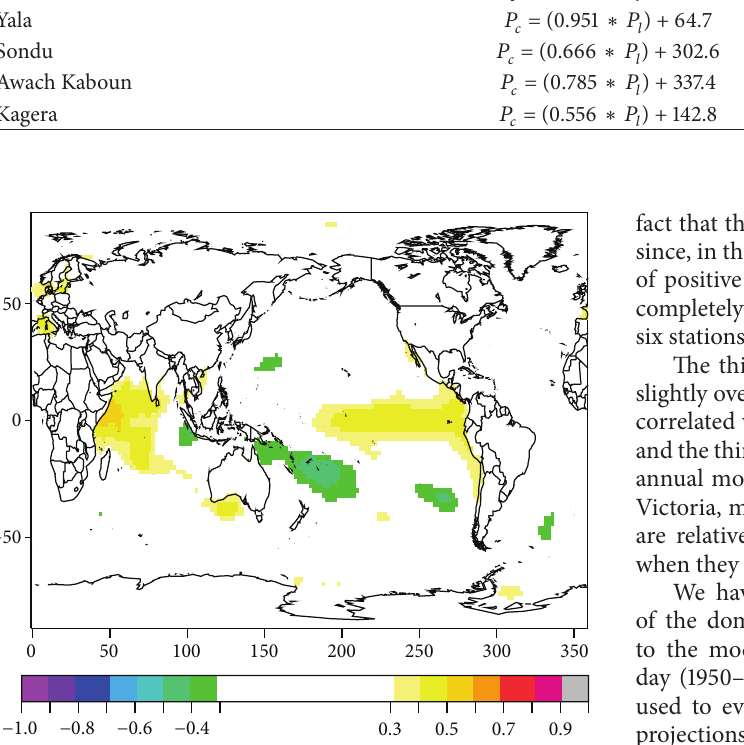
Figure 6: Pearson Correlation of the time series for the first mode of OND season precipitation variability with ERSST sea surface temperatures.